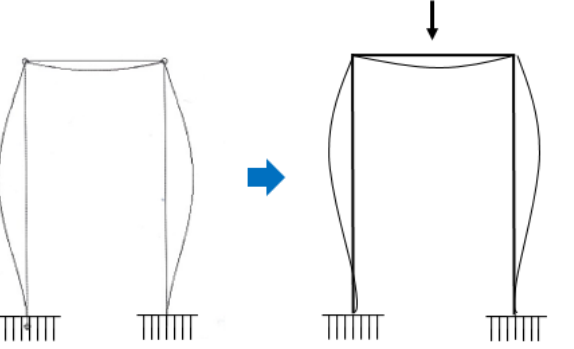
Figure 5. Idealization of approximate analytical approach for symmetric mode.